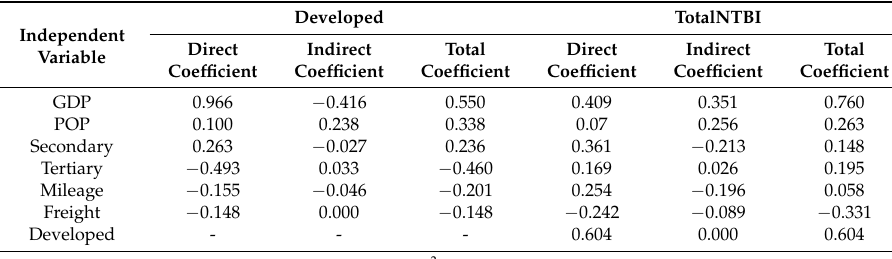
Figure 9. Path diagram of the direct/indirect effects of factors in the structural equation model (SEM). Note: The numbers above the arrowed lines denote direct coefficients. Table 5. Summarized coefficients of SEM.